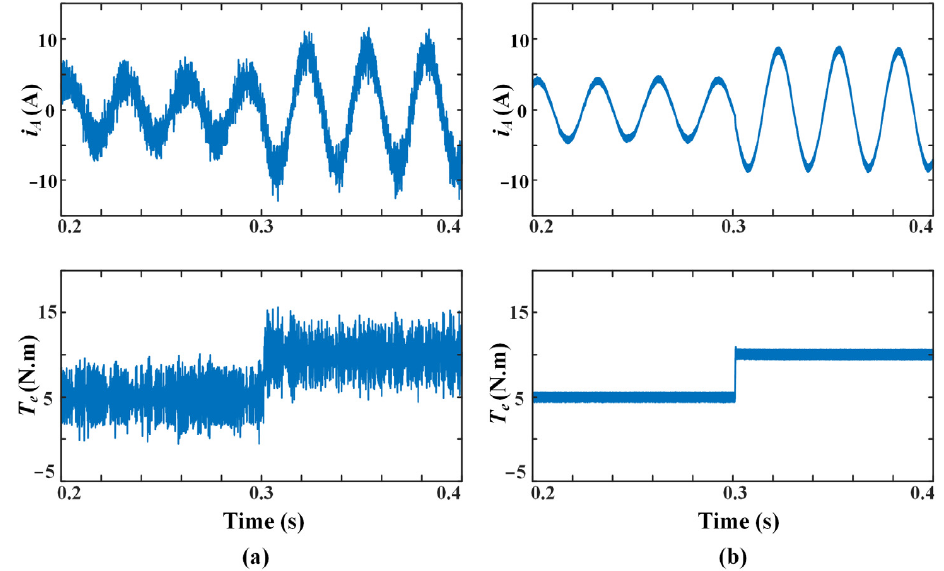
Figure 10. Steady-state performance with a load of 10 N.m. ( a ) Conventional VV-MPC; ( b ) proposed MVV-MPC.